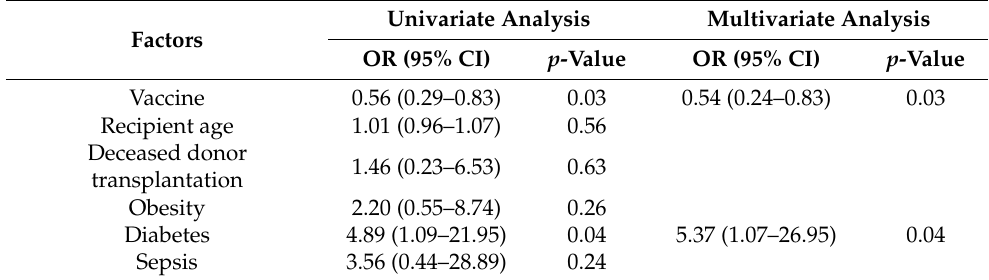
Table 4. Univariate and multivariate analysis of factors associated mortality in COVID-19 infected kidney transplant